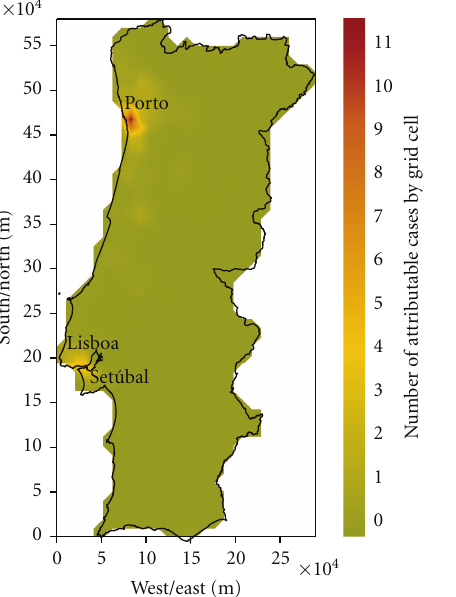
Figure 11: Prevented cases considering the fulfilment of the legis- lated value (deaths · 100000 inhabitants − 1